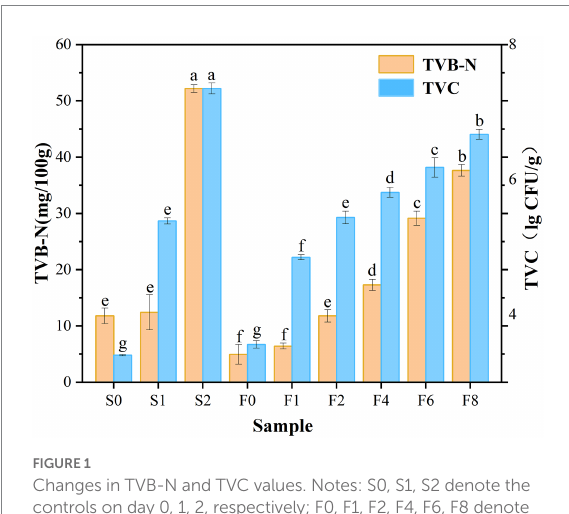
FIGURE 1 Changes in TVB-N and TVC values. Notes: S0, S1, S2 denote the controls on day 0, 1, 2, respectively; F0, F1, F2, F4, F6, F8 denote zaoyu on day 0, 1, 2, 4, 6, 8, respectively; Z denotes the fermented rice. Different letters (a, b, c etc.) indicate significantly different means at p < 0.05 (analysis of variance; ANOVA). The same